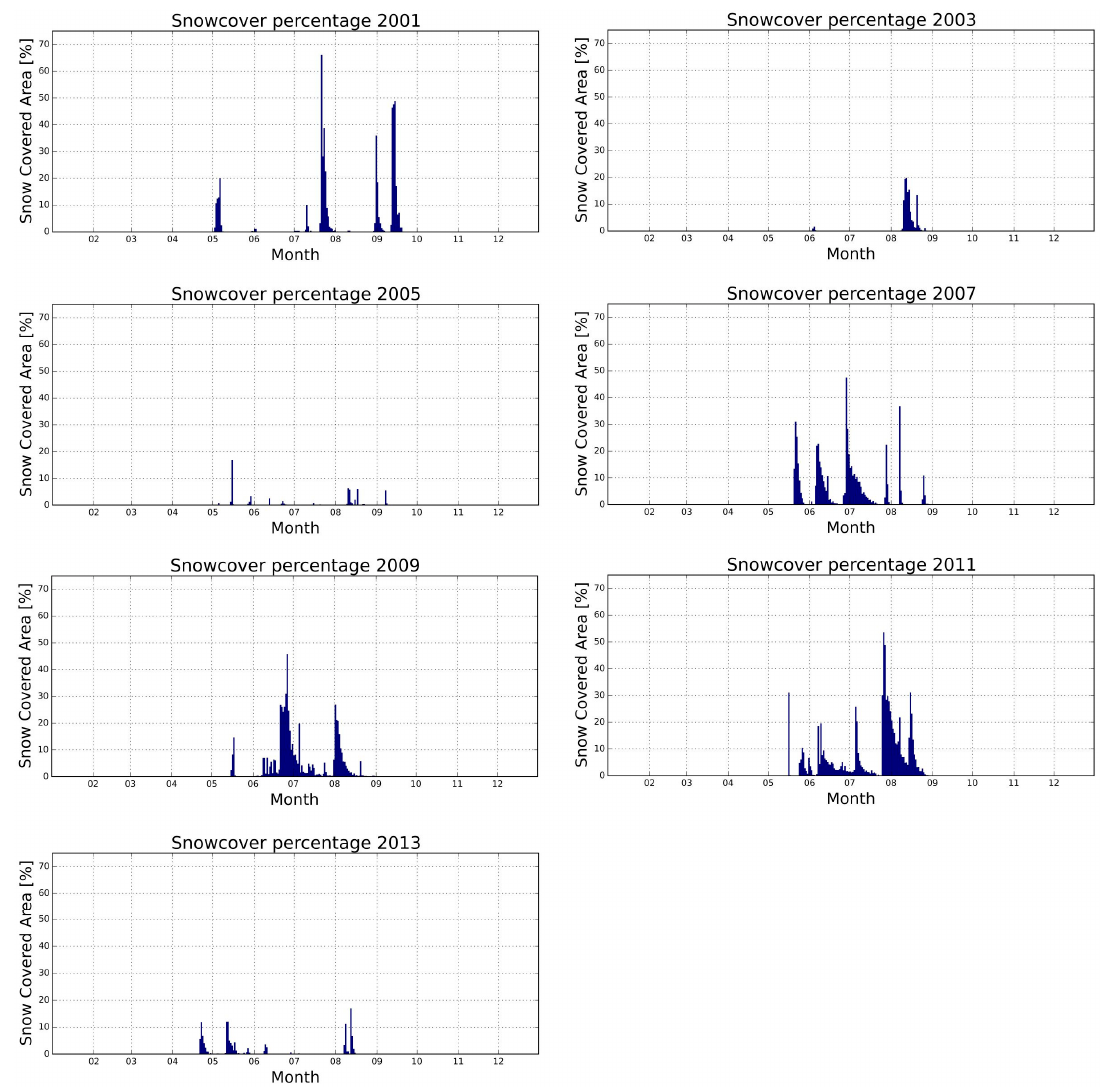
Figure A1. Snow covered area (%) of Lesotho between 2000 and 2014; compiled at daily temporal resolution. (Note: only odd years are shown. The even numbered years are included in the main paper as Figure 5.) The maximum snow cover extent that was observed during the winter season (July and August) is clearly shown; the occurrence of occasional snow events was also observed during June and September.